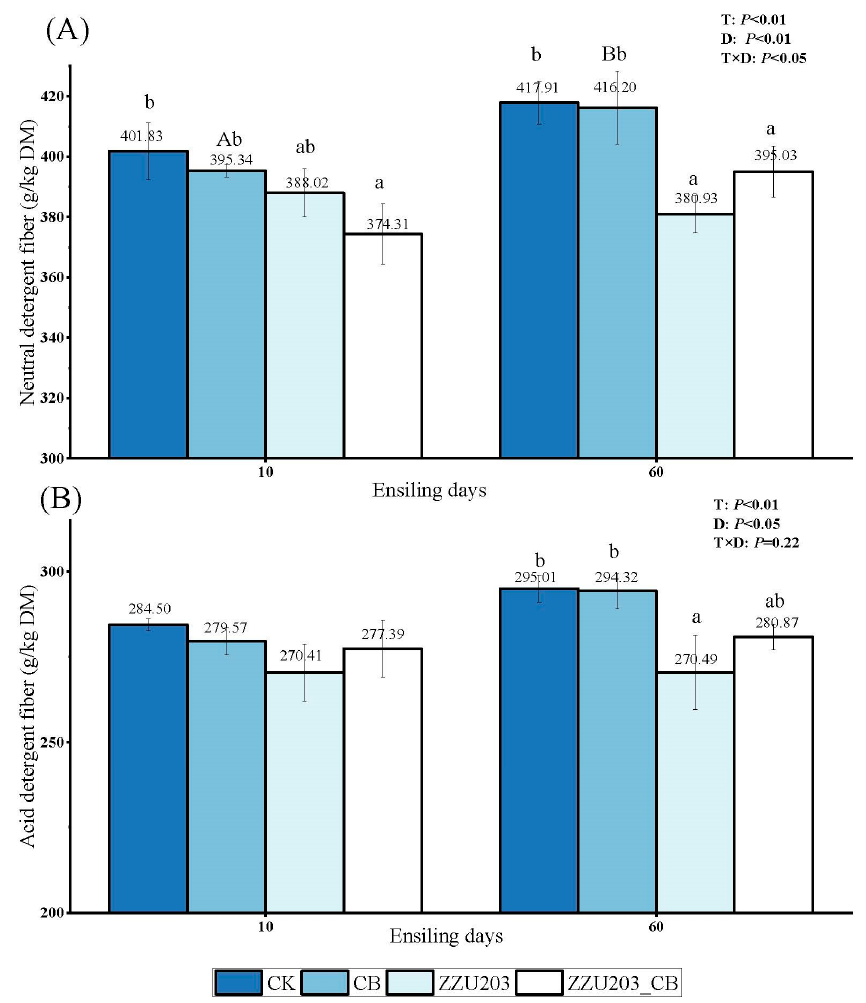
Figure 3. Changes in neutral detergent fiber (NDF) ( A ) and acid detergent fiber (ADF) ( B ) in alfalfa silages during ensiling for 60 d. Values with different superscript lowercase letters show significant differences between treatments on the same ensiling day, while values with different superscript capital letters show significant differences between ensiling days with the same treatment ( p <